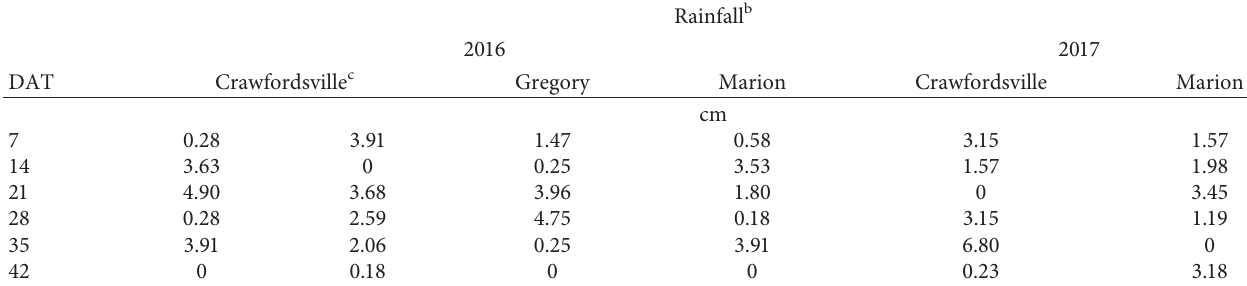
Table 2: Accumulated rainfall following PRE herbicide application from 12 trials conducted near Crawfordsville, Gregory, and Marion, Arkansas, in 2016 and 2017 a